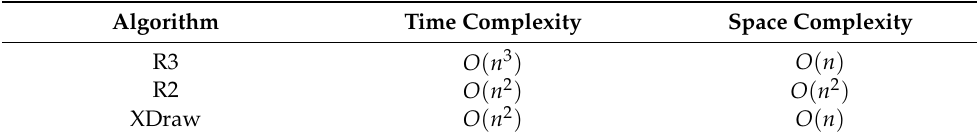
Table 1. The time and space complexities of three grid-based viewshed algorithms.